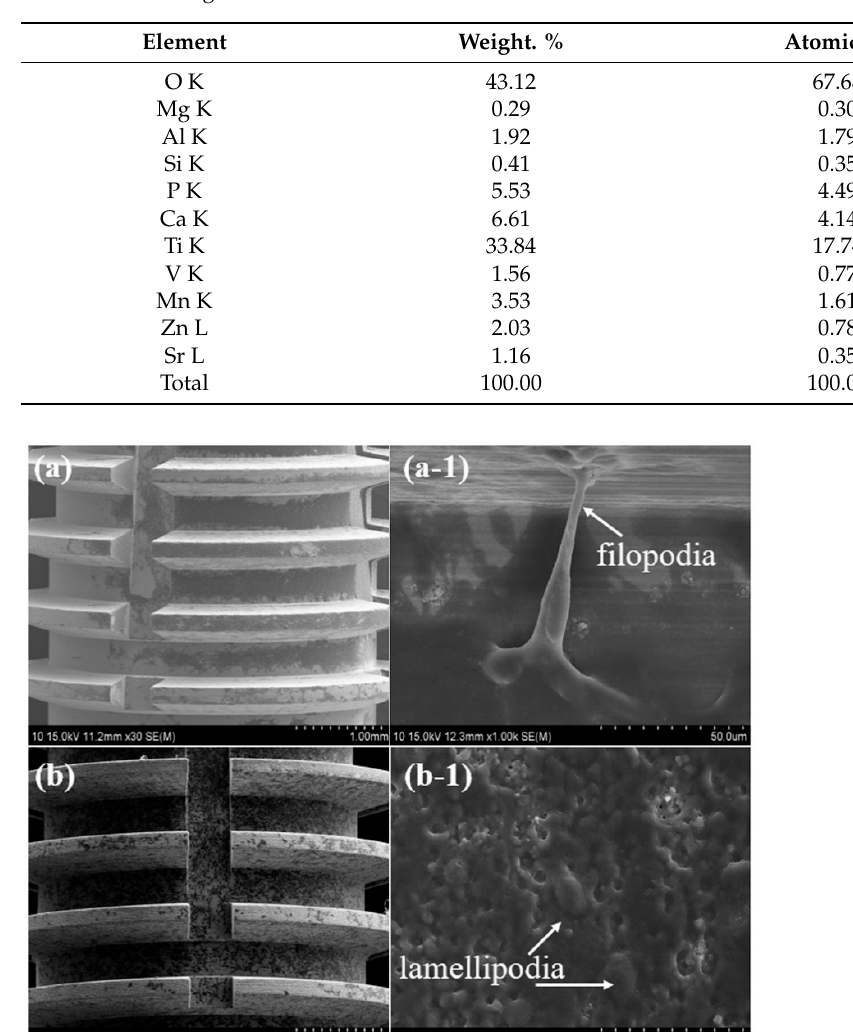
Figure 5. SEM images of the osteoblast cells cultured on the surface of Ti-6Al-4V alloy implants: ( a , a-1 ) Ti64/SA implants and ( b , b-1 ) Ti64/7 ion implants.